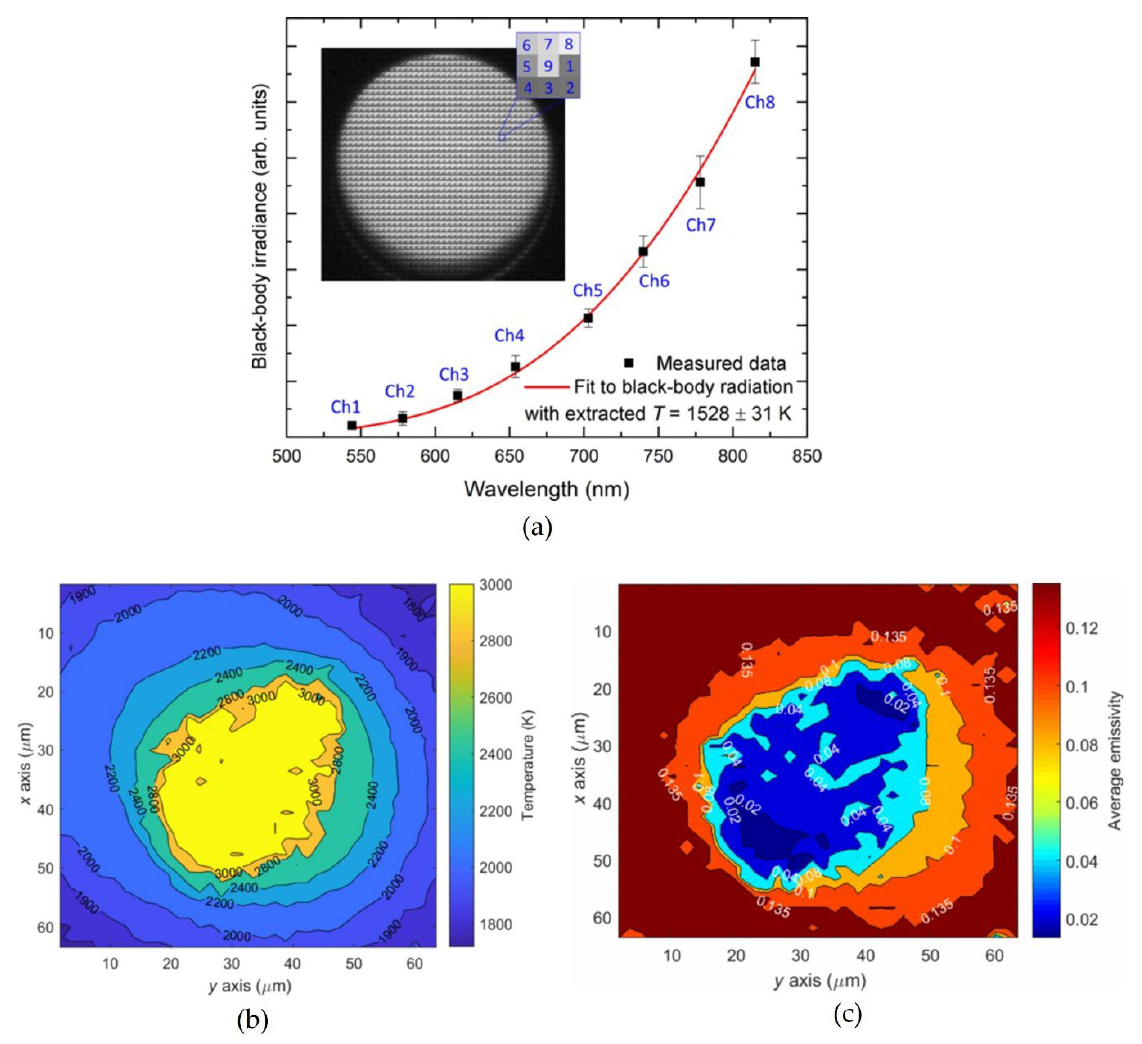
Figure 12. ( a ) Spectral radiance measured by the hyperspectral camera when imaging a known blackbody source cavity at a temperature of 1473 K. The experimental data fit well with the prediction based on Planck’s law for blackbody radiation. Inset: raw image of the blackbody source cavity consisting of a matrix made up of groups of 3 × 3 spectral-band-filtered pixels called macropixels. An enlarged view of the nine interleaved pixels in a macropixel is shown in the top right corner. ( b ) Temperature-profile measurements during laser heating. ( c ) Emissivity profile measurements during laser heating